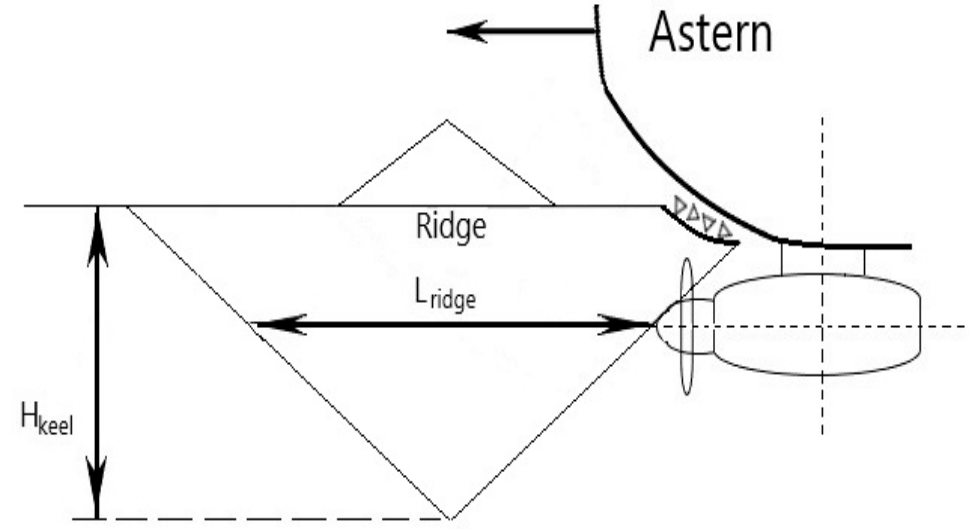
Figure 10. Scheme of astern movement in first-year ridges of an arctic icebreaker equipped with an electric azimuth unit. H keel —the depth of ridge keel; L ridge —the width of ridge keel. Ship speed is in knots and time is in seconds. Table 2. The main characteristics of the propeller on the Arctic icebreaker. D, m EAR H/D N, kW 4.5 0.714 0.944 8775